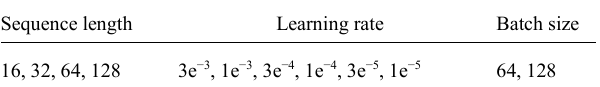
P OSSIBLE V ALUES FOR H